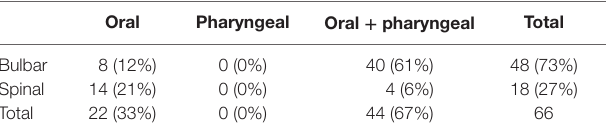
TaBle 2 | impairment of the swallowing phases detected by Fees in bulbar and spinal als patients.